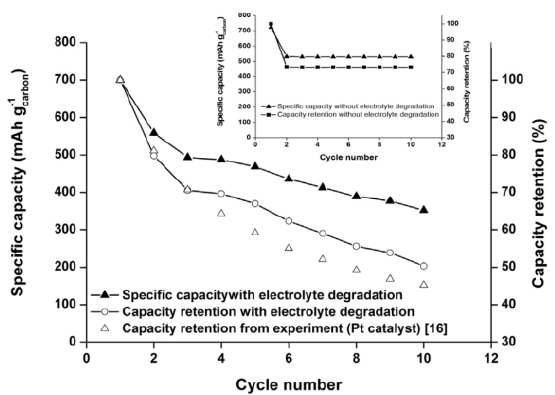
Figure 27. Cyclic performance (discharge capacity and capacity retention against cycle number) of a 10-cycle rechargeable Li-air battery considering Li 2 CO 3 formation by electrolyte degradation. Reprinted from Sahapatsombut et al. [37], with permission from Elsevier.